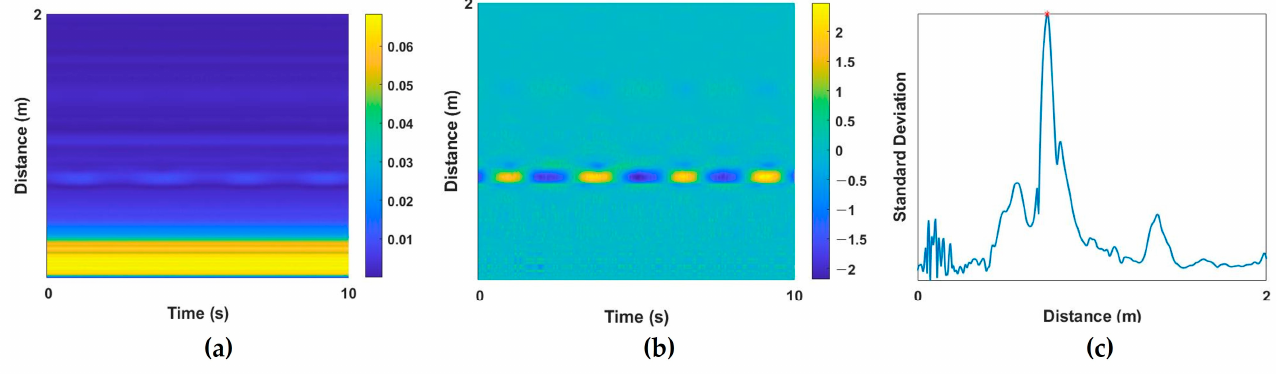
Figure 2. Example of preprocessing steps. UWB data ( a ) before and ( b ) after clutter removal; ( c ) standard deviation of the distance of each signal for target localization.